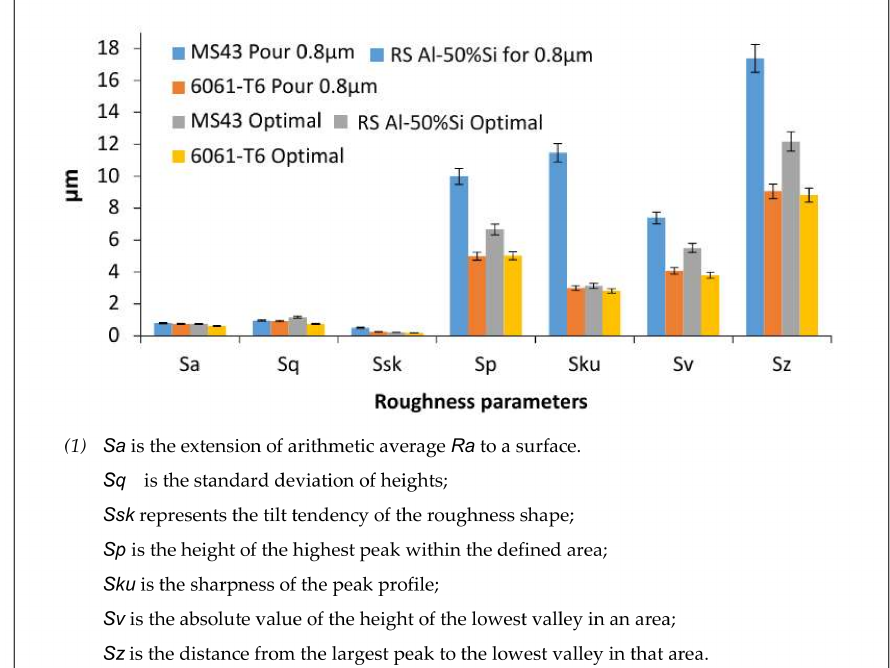
Figure 9. Comparison of di ff erent parameters ( 1 ) of surface roughness for the two alloys (Tool 3).